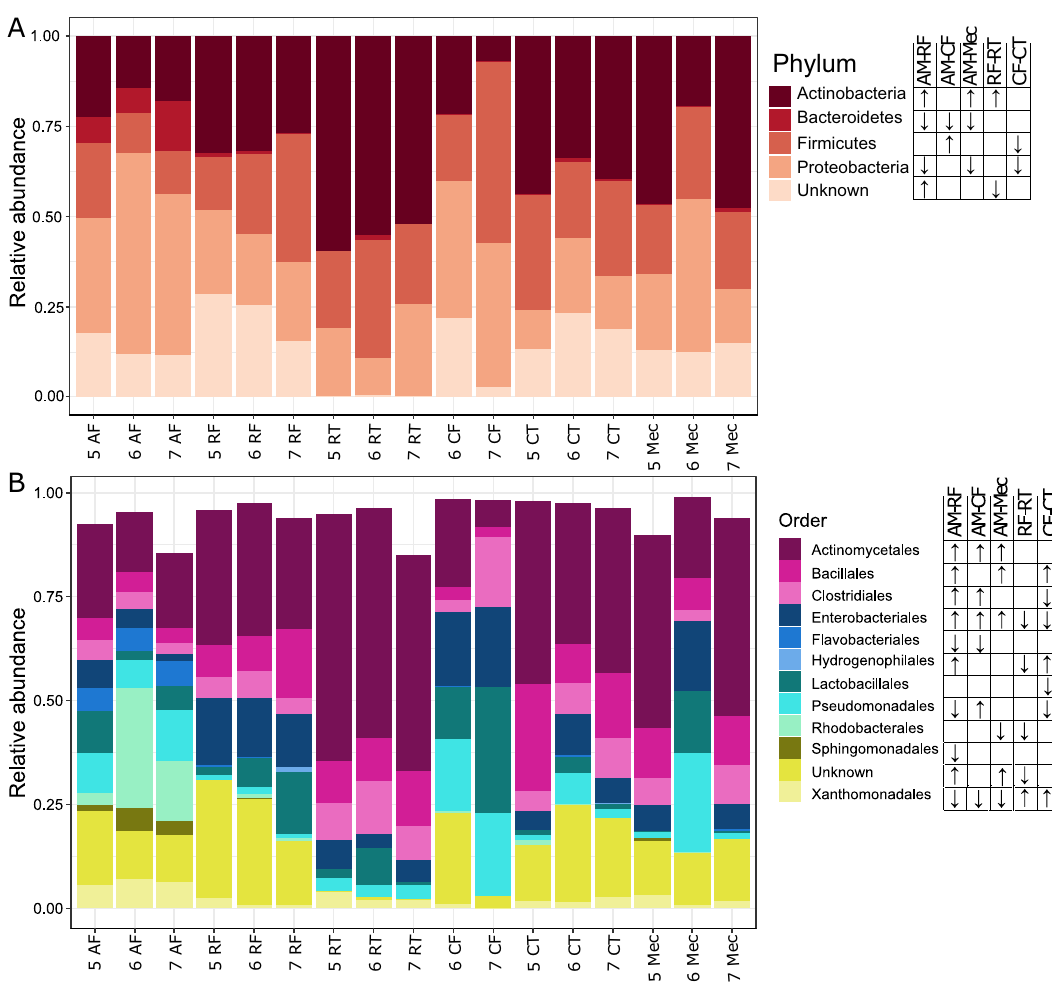
Figure 4. Mean relative abundance of bacterial phylum level ( A ) and order level ( B ) ESVs in each sample type (GIT component and amniotic fluid) at each gestational age (5, 6 and 7 months). Significant phylum-level and order-level changes in relative abundance between sample types are denoted next to the taxonomic key. For each pair of sample types, the arrow indicates the direction of change in abundance in the second sample type relative to the first. ESVs are clustered by colour to the levels of phylum and order. ESVs with taxonomic assignments at the phylum level and order level with confidence values lower than 90% are denoted as ‘Unknown’. Levels of gDNA in caecal fluid from foetuses at 5 months gestation were below the concentration threshold (0.5 ng/µL) for samples to be included in the sequencing run. Amniotic fluid (AF), ruminal fluid (RF), ruminal tissue (RT), caecal fluid (CF), caecal tissue (CT), meconium